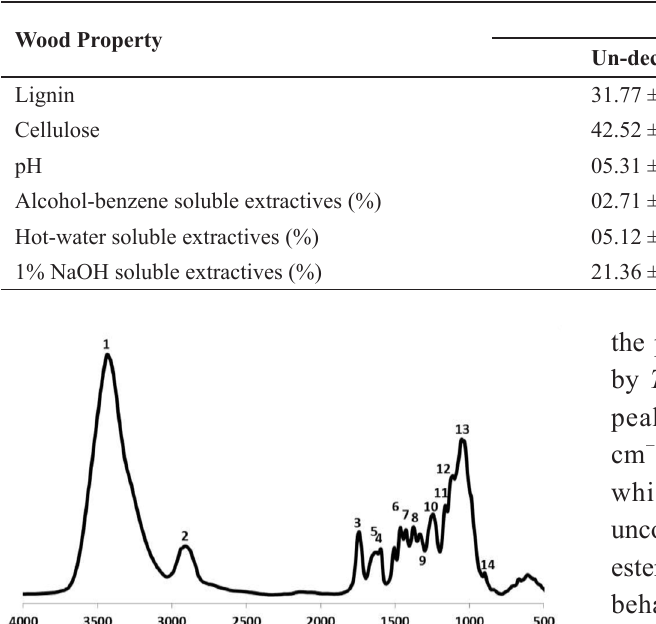
Average of percent chemical components in decayed hornbeam wood in sound and naturally infected sample by white-rot fungus Trametes versicolor .